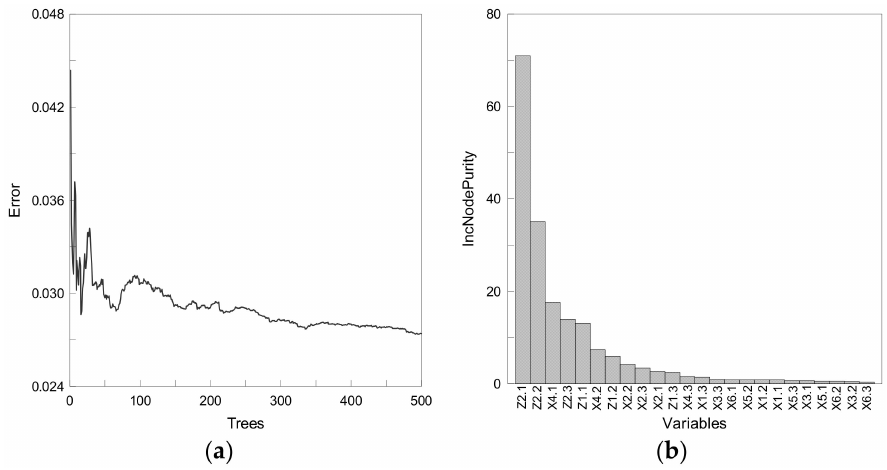
Figure 11. ( a ) Error by number of trees; ( b ) Importance of variables.